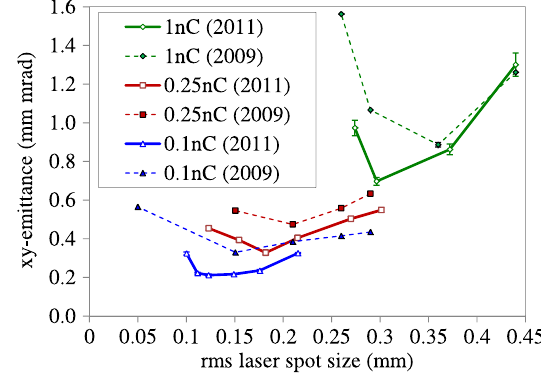
FIG. 11. Measured rms normalized emittance as a function of the rms laser spot size at the cathode. For comparison the results of the optimization in 2009 are plotted with dashed lines. The statistical error bars (see Sec. IVA 6) are included in the graph butsmallstatisticalerrorbarsarehiddenbehindmarkersintheplot.